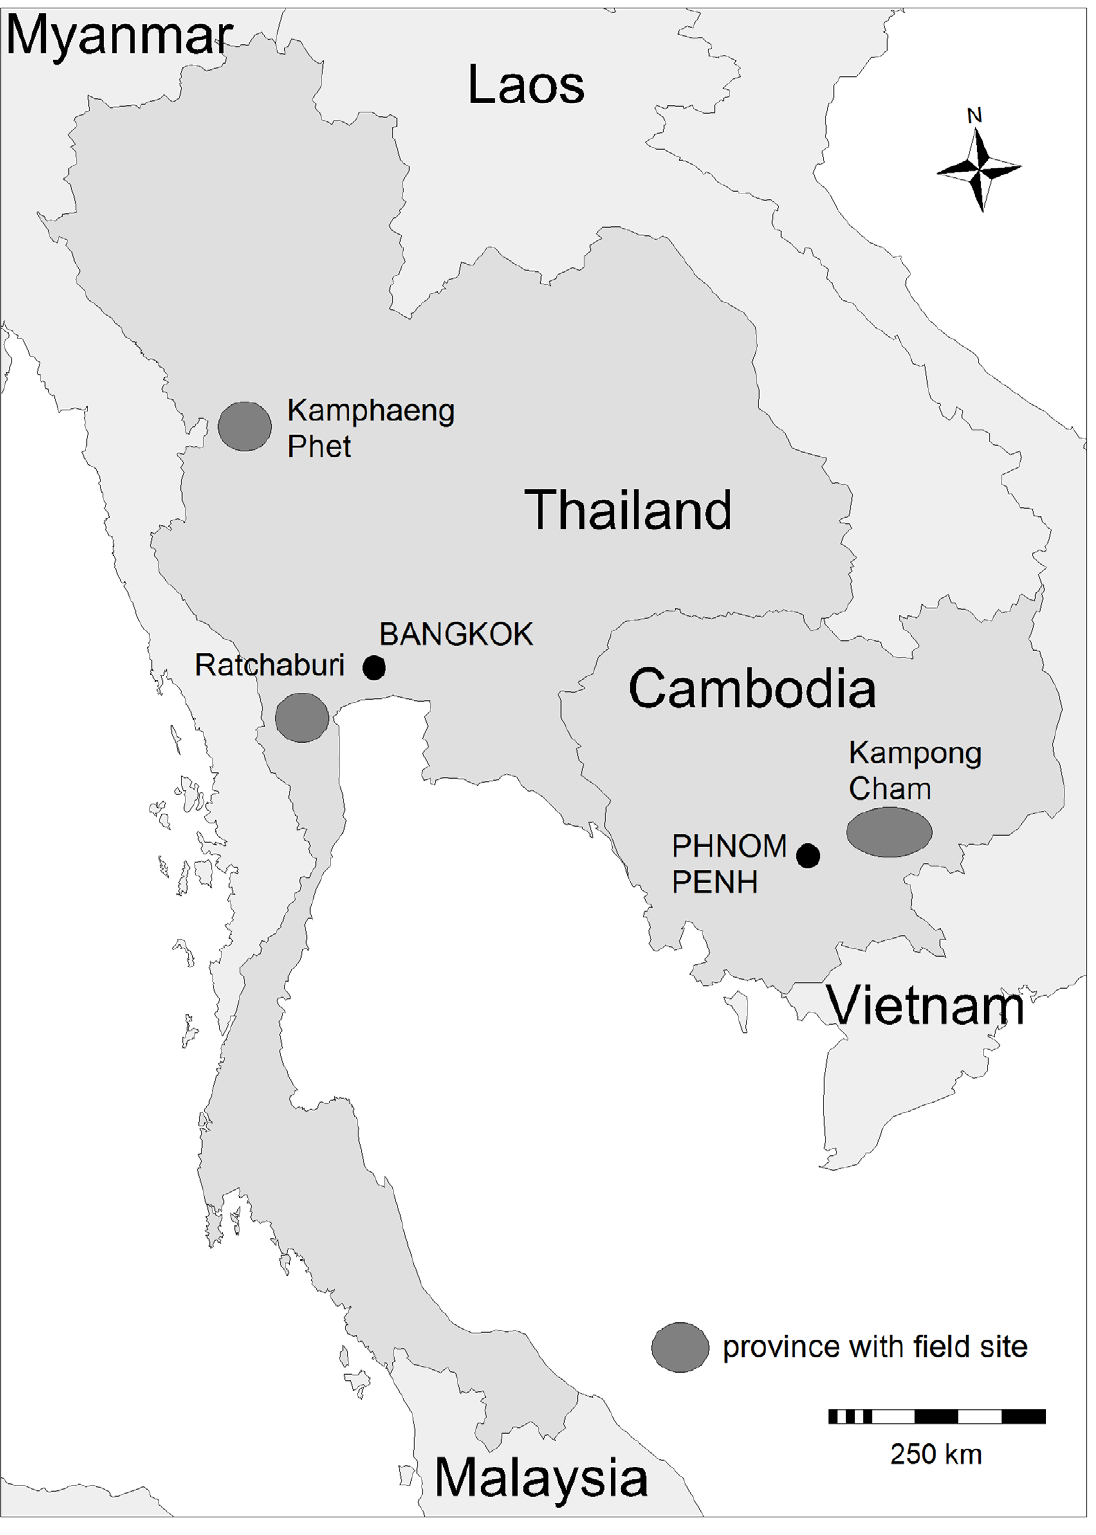
Figure 1. Geographic location of provinces with dengue field sites in Thailand and Cambodia. The field sites were members of a dengue field site consortium and provided prospective cohort data to be compared with the dengue reporting data in the same province.